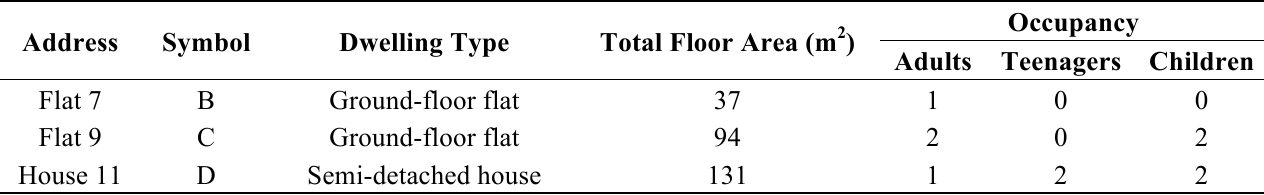
Table 2. Housing units’ characteristics and occupancy patterns in Cross Street Development.